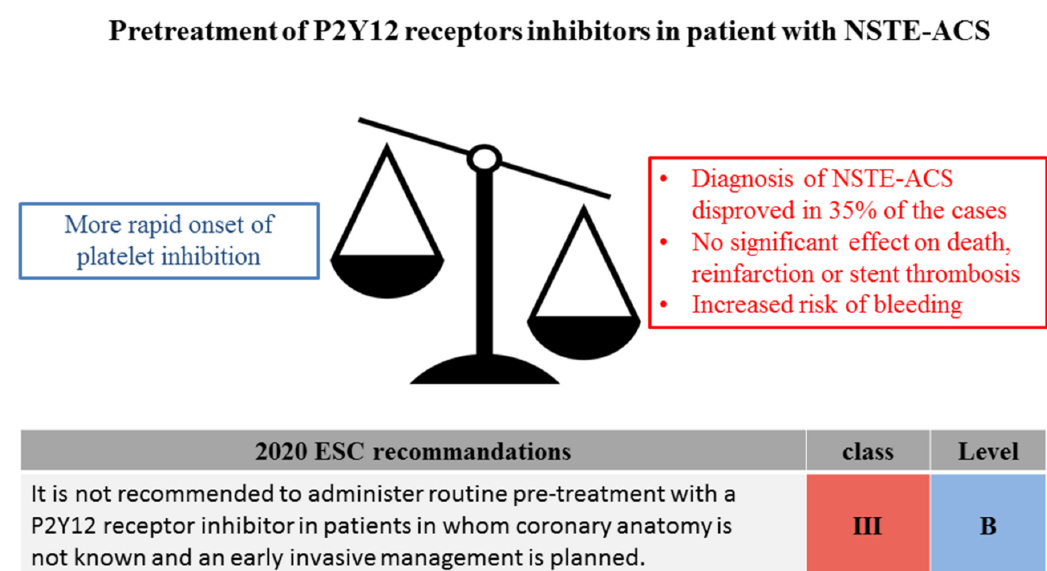
Figure 2. Pretreatment with P2Y 12 receptors inhibitors in patients presenting with non-ST-segment elevation myocardial infarction. NSTE-ACS: non-ST-segment elevation myocardial infarction; ESC: European society of Cardiology.